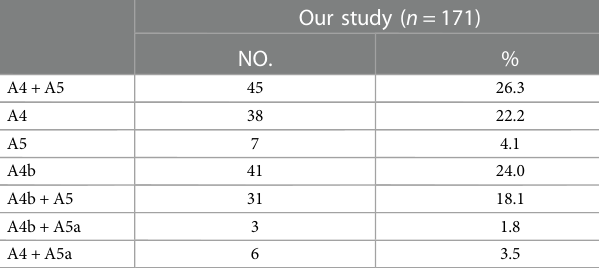
the following three types ( Table 8 , Figure 5 ): type I, the MLA